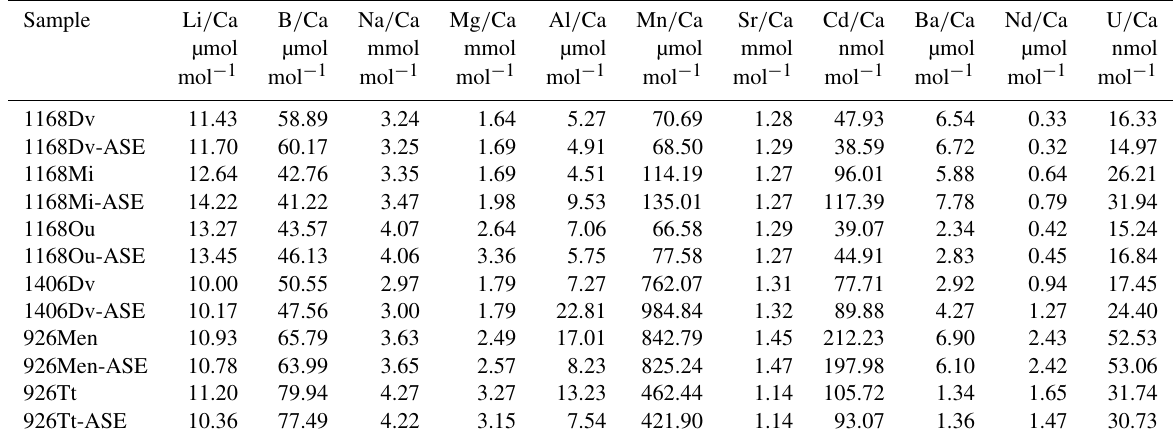
Table 3. Trace element results for ASE-treated and non-ASE samples. DV: D. venezuelana ; Mi: G. miotumida ; Ou: O. universa ; Men: G. menardii ; Tt: T. trilobus